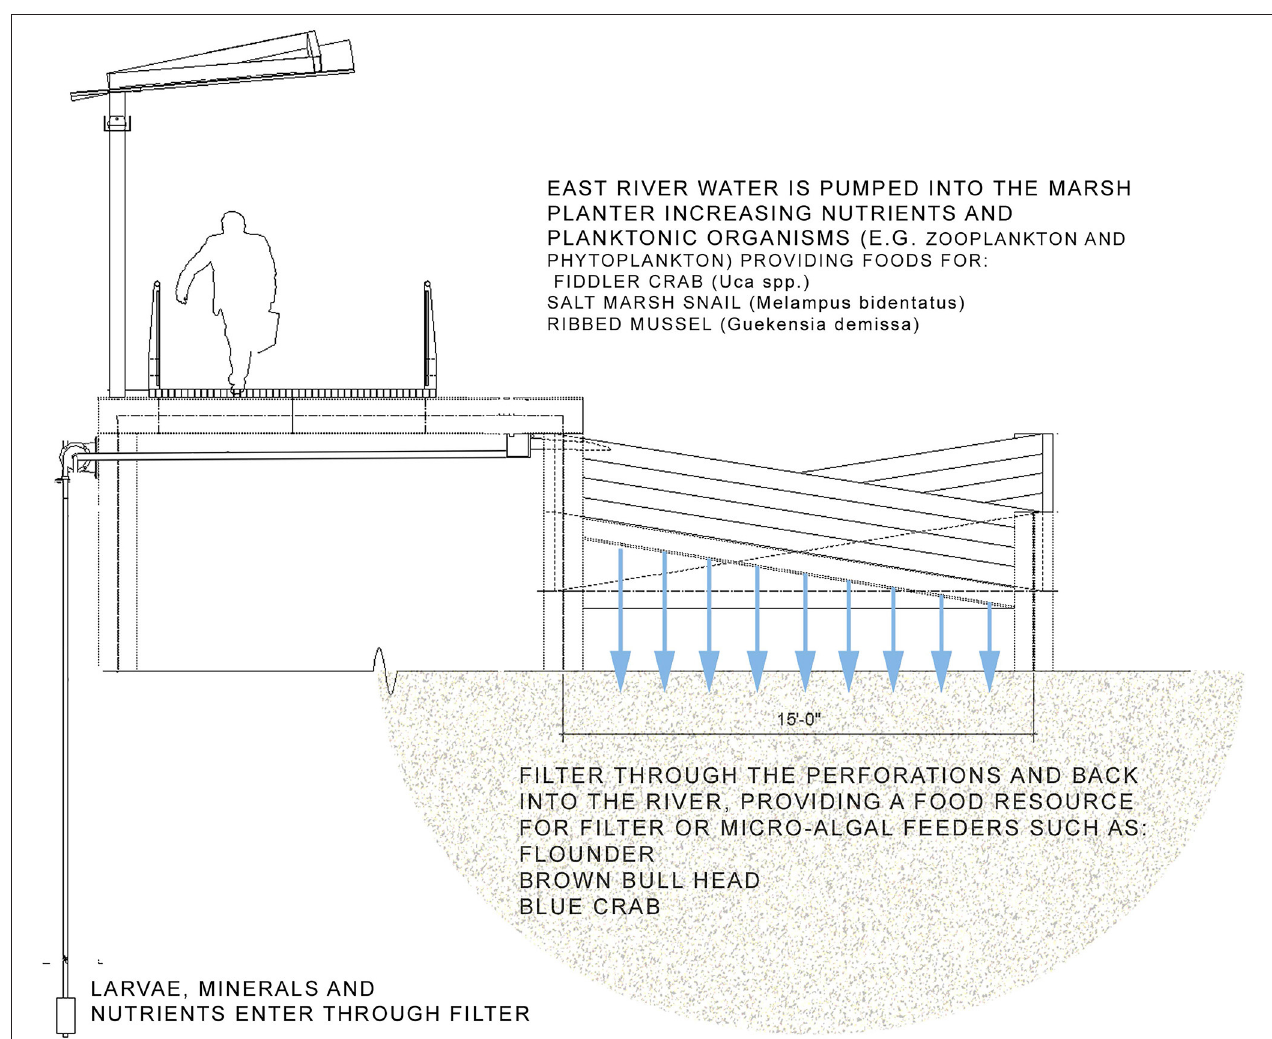
FIGURE 8 | The proposed design for the East River Marsh Planter is an example of Creative and Aspirational Ecological Design. Design by Ken Smith Landscape Architect; drawing by Alexander Felson and used with